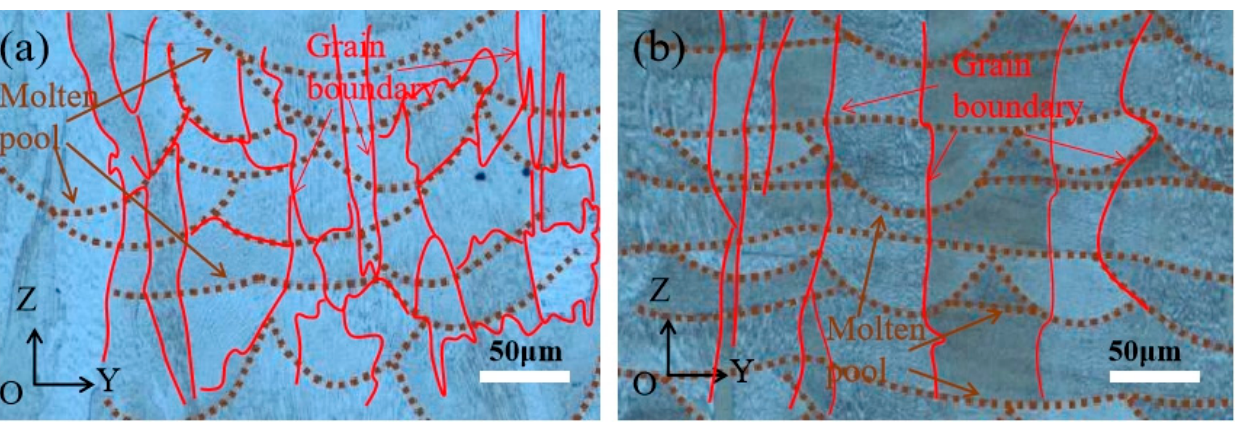
Figure 3. Molten pool morphology of YOZ surface of samples prepared at different rotation angles between adjacent layers. ( a ) 67°; ( b ) 90°.